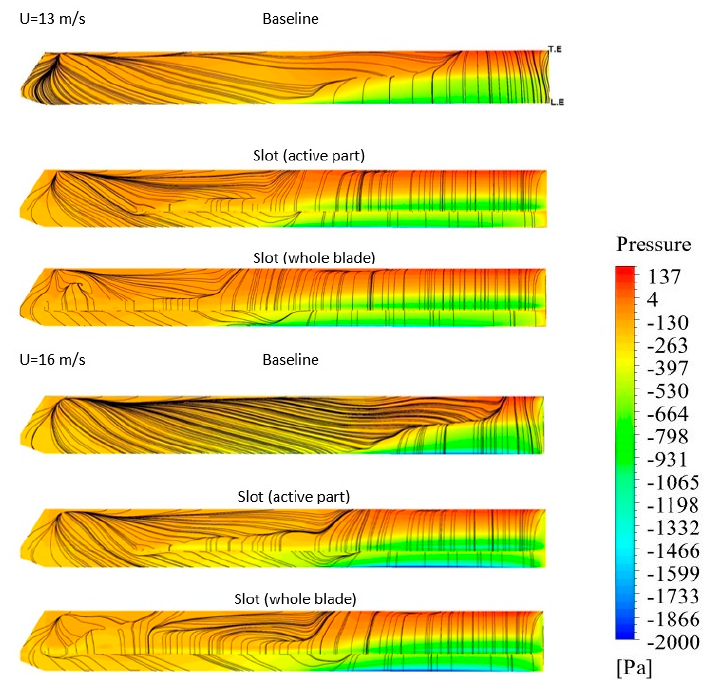
Figure 9. Comparative view of the streamlines on the upper surface of the blade, comparison between configuration 1 (whole blade), configuration 2 (active part), and the baseline (top).